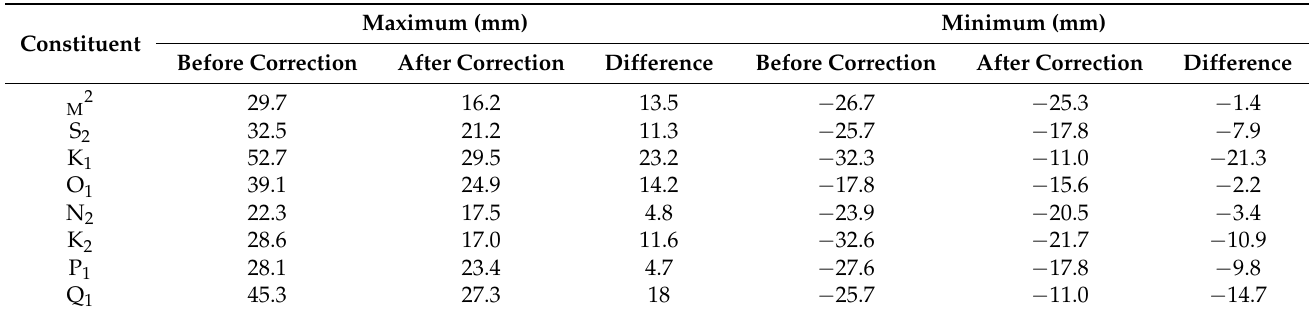
Table 8. The extreme values of amplitude changes before and after the MVC of the eight major constituents in the South China Sea.